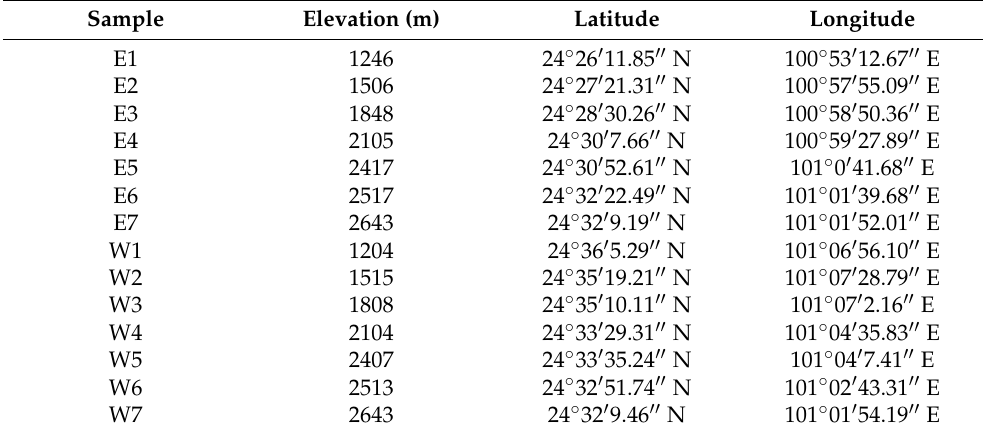
Table 1. Samplesofelevation, altitude, andlongitudeofsoilsoneastandwestslopewithdifferentaltitudes.